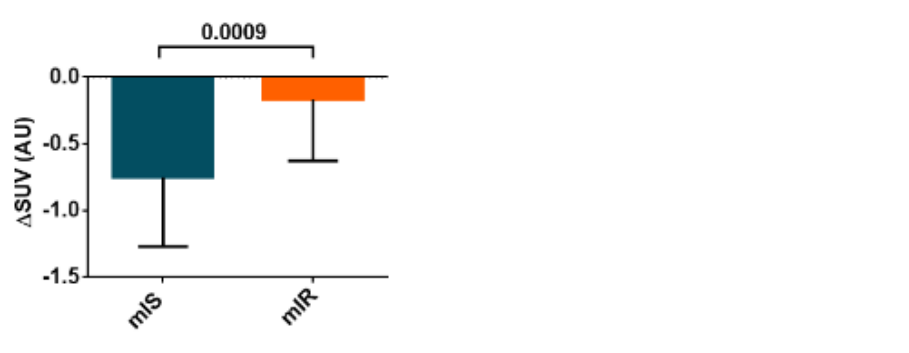
Figure 4. Results of liver assessment of fibrosis by fibroscan of both groups patients with T2D (mIR and mIS). Data are shown as median ± SD.